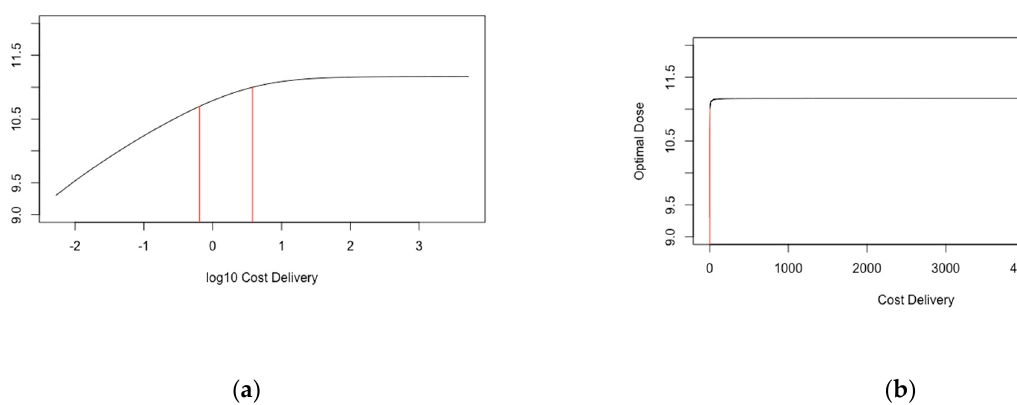
Figure 4. Optimal predicted dose for +/ − 3 orders of magnitude around Cost Delivery . ( a ) has Cost Delivery at a log10 scale and ( b ) scaled normally. The black line represents the optimal dose, and the red lines indicate the threshold values of Cost Delivery for which optimal dose is 1 × 10 11 and 5 × 10 10 VP.